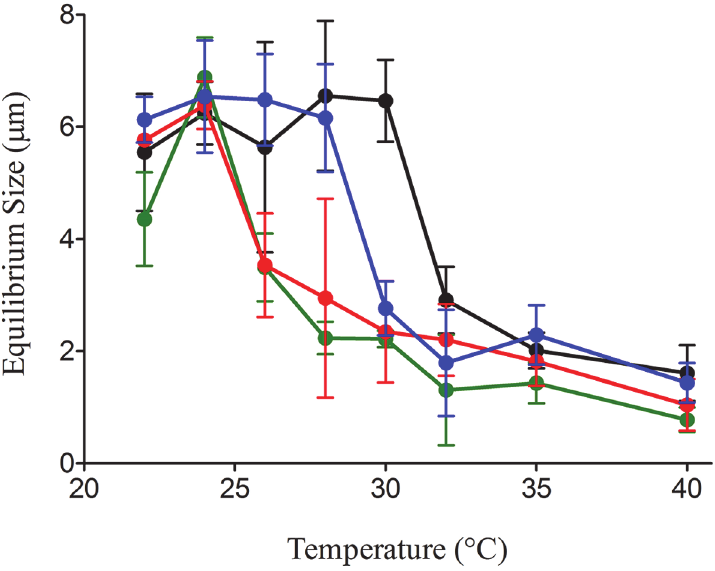
Fig 2. Dispersion-temperature of microgels decreases at lower pHs. As pH is reduced from 8.0 (black) to 7.7 (blue) to 7.5 (red) to 7.3 (green), non-linear microgel dispersion-temperature changes were observed while pH decreases. Dispersion temperature dropped ~2 ˚ C with a 0.2 pH decrease. Each data point represents mean (+/ − SD) of six measurements made in each of six replicate